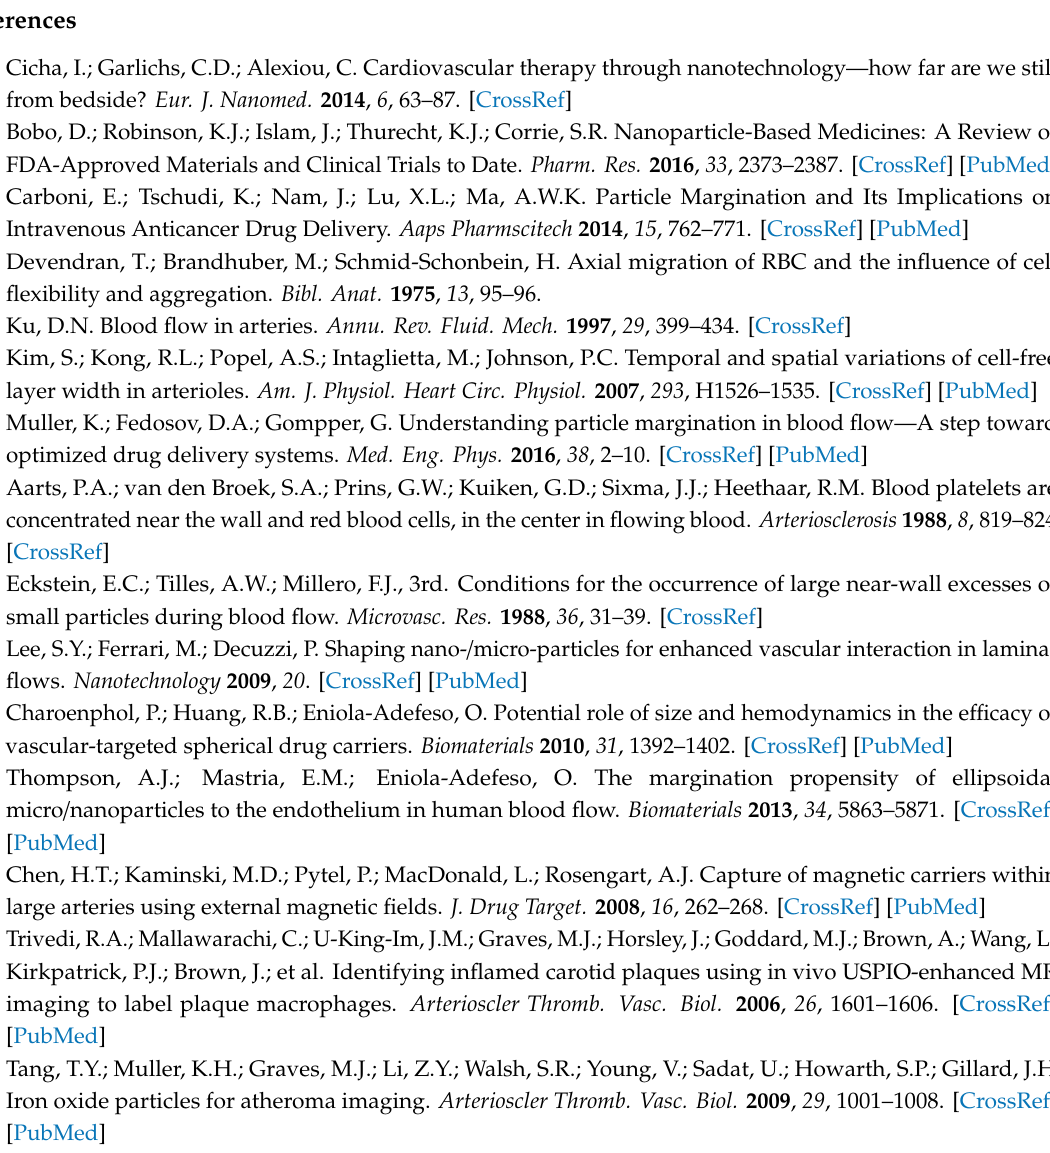
Figure A3. SPION entrapment in the clot formed in the artery lumen. Histological evaluation of example experiments with whole blood is shown in 20 × magnification. Iron was detected using Prussian blue stain.